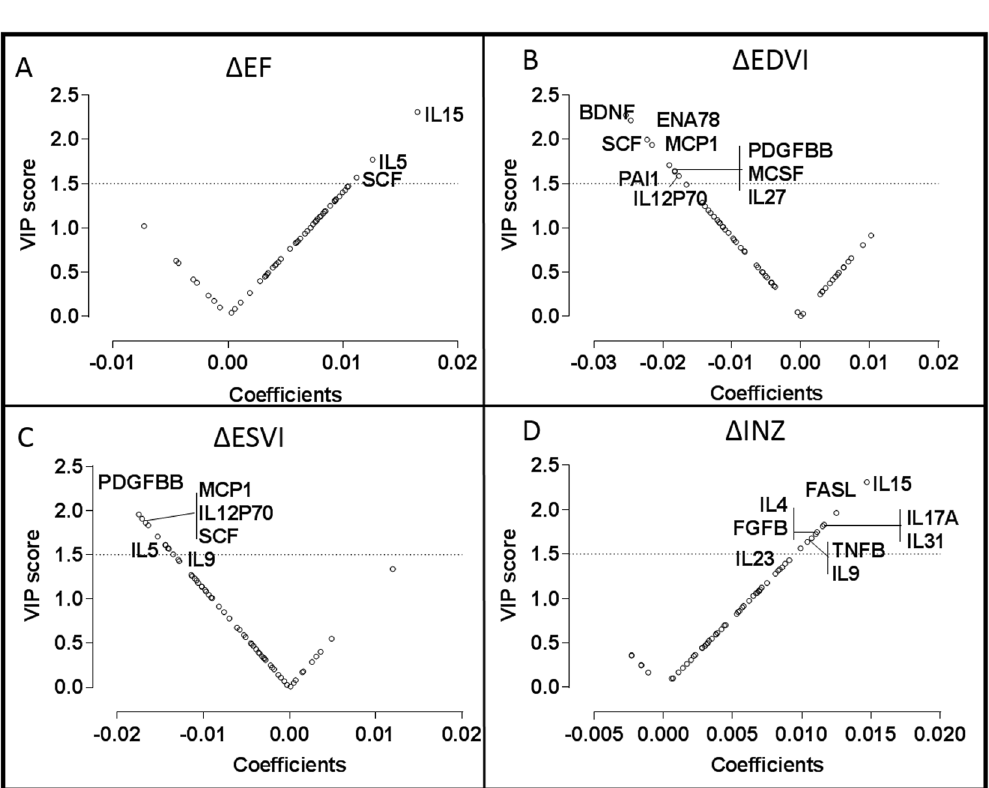
Figure 3. V-plots for continuous PLS-DA models generated with extracted VIP and correlation coefficient values for the BMC-treated subjects. Biomarkers with high VIP ( > 1.5) and coefficient values are named. V-plots for continuous change in in ( A ) EF, ( B ) EDVI, ( C ) ESVI, and ( D )